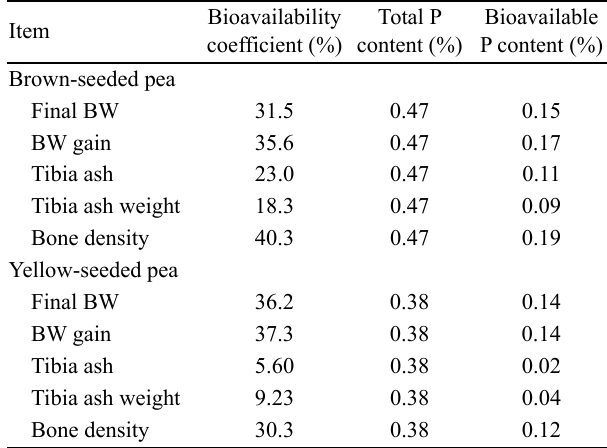
Table 5. Bioavailability of P in two pea cultivars for broilers based on body weight gain, feed intake, feed conversion ratio, tibia ash and bone mineral